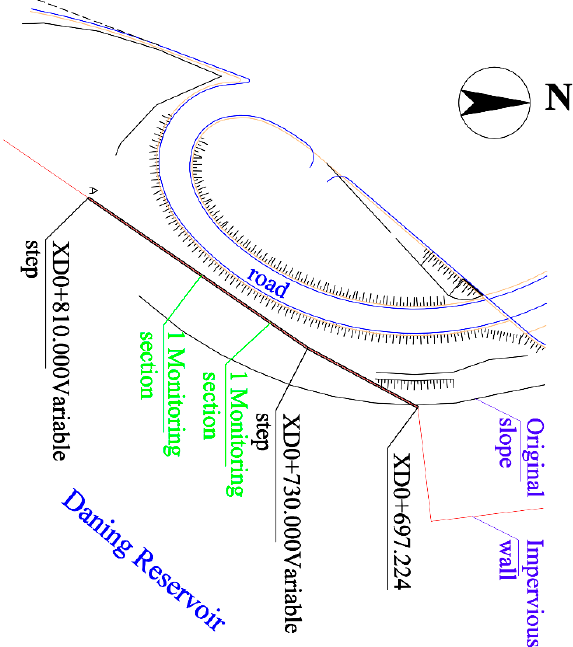
Figure 1. Location layout of monitoring sections and selection of numerical simulation sections.